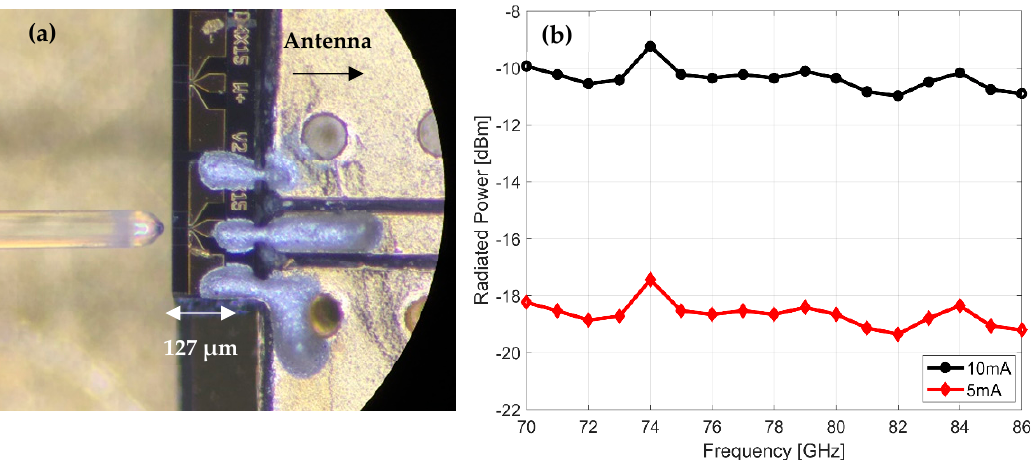
Figure 3. ( a ) Micrograph of test structure showing UTC-PD chip with coplanar pads integrated with planar antenna, along with a lensed fiber coupling and ( b ) measured radiated power in E-Band at bias voltage of − 3 V.